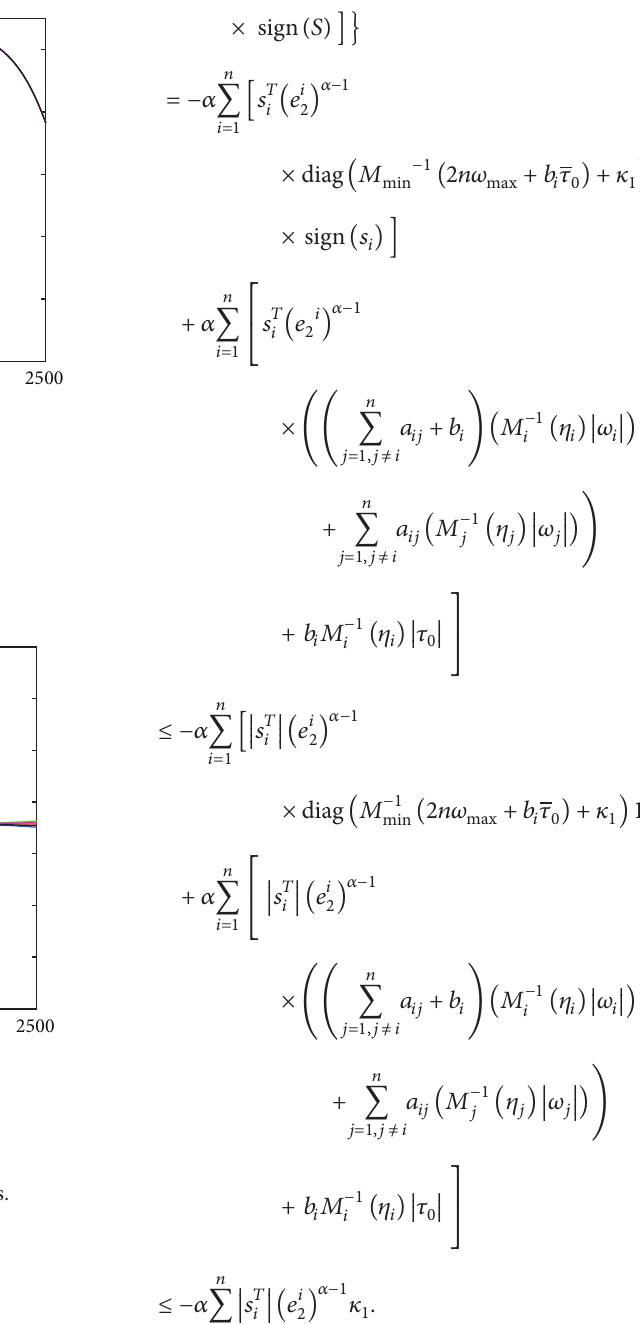
) 2 ) 𝑀 −1 (𝜂) 𝜔 3 ) (1 ⊗ (𝑀 −1 (𝜂 ) 𝜏 )) 3 𝑛 0 0 0 (2𝑛𝜔 + 𝑏 𝜏 ) + 𝜅 ) , max 𝑖 0 1 min (2𝑛𝜔 + 𝑏 𝜏 ) + 𝜅 . . . , diag (𝑀 −1 max 𝑖 0 1 min